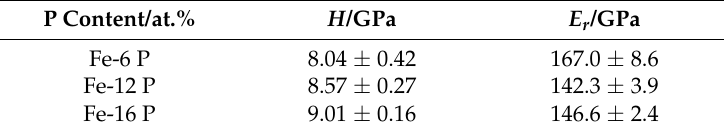
Table 5. Hardness H (GPa) and Young’s modulus E r (GPa) of the Fe-P coatings with P (6 at.%; 12 at.% and 16 at.%).